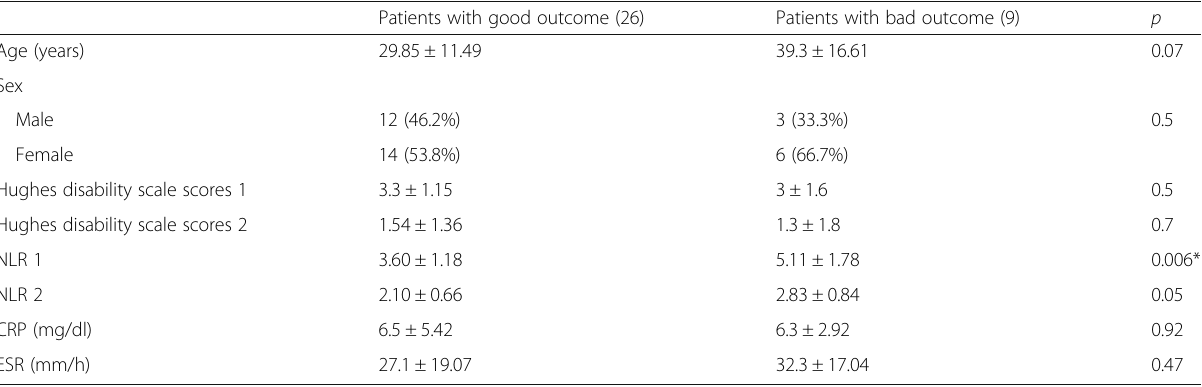
Table 3 Comparison between patients showing good response to treatment and those not responding to plasmapheresis Patients with good outcome (26)